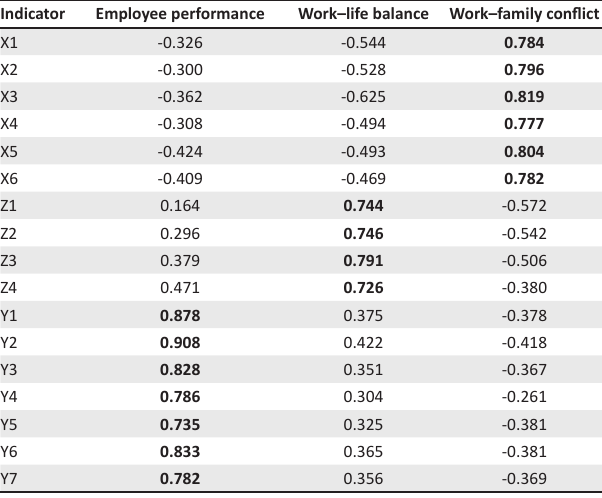
TABLE 4: Cross-loading calculation results. Indicator Employee performance